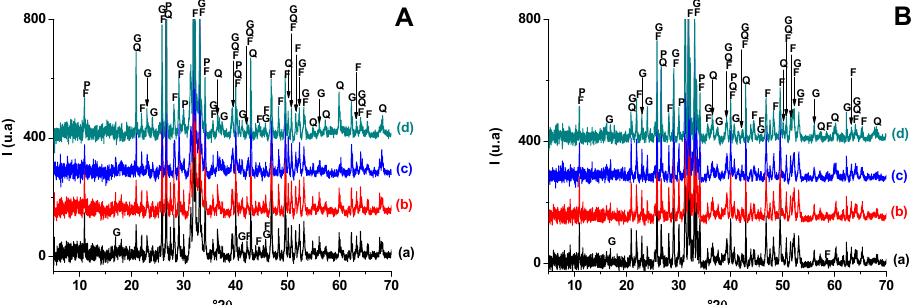
Figure 6. X-ray diffraction patterns of SA-PS (50 wt. % of SA) blends heated at 900 °C ( A ) and 1100 °C ( B ). (a) SA-PS; (b) SA-PS-SC (5wt. % of SC); (c) SA-PS-SC (10 wt. % of SC); (d) SA-PS-SC (20 wt. % of SC). G: Gehlenite (PDF # 72-2128); Q: Quartz (PDF # 79-1911); F: Fluorapatite (PDF # 83-0556); P: Calcium phosphates (PDF # 11-0232).